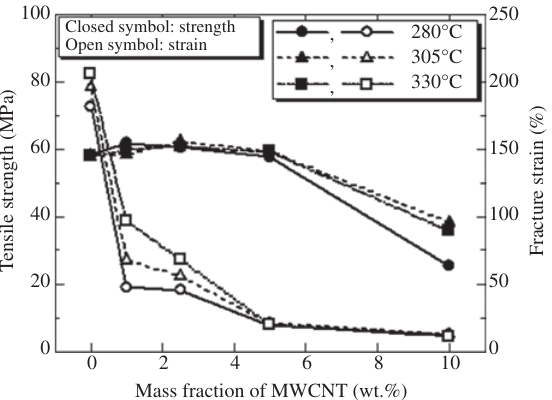
Figure 2: Tensile strength and fracture strain of the PC and the MWCNT/PC composite obtained at the injection speed of 10 mm/s.